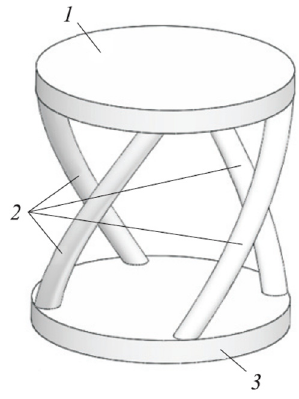
Figure 1. Structure and principle of operation of the longitudinal–transverse transducer: (1) linear displacement entry platform; (2) screw rods; (3) exit platform, performing rotary displacement.